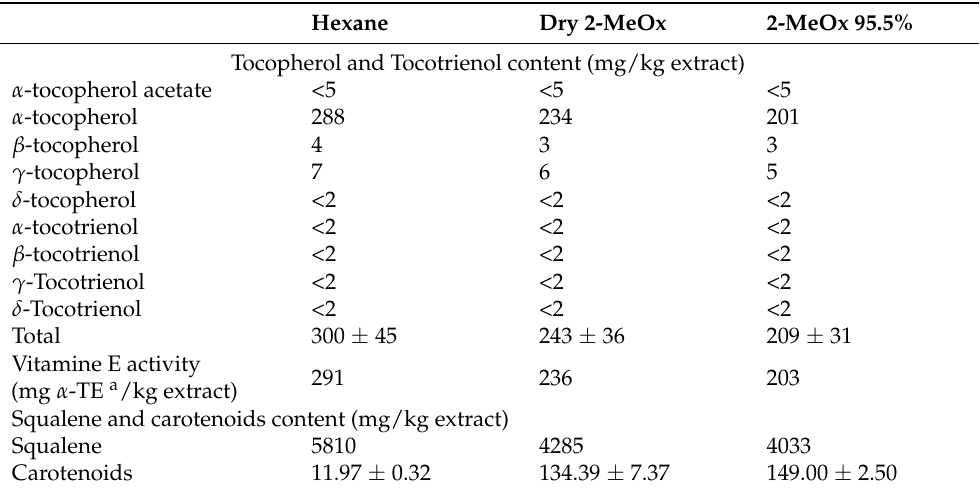
Table 4. Tocopherol, tocotrienol, squalene and carotenoids content in OP extracts obtained with hexane, dry 2-MeOx and 2-MeOx 95.5%. Hexane Dry 2-MeOx 2-MeOx 95.5% Tocopherol and Tocotrienol content (mg/kg